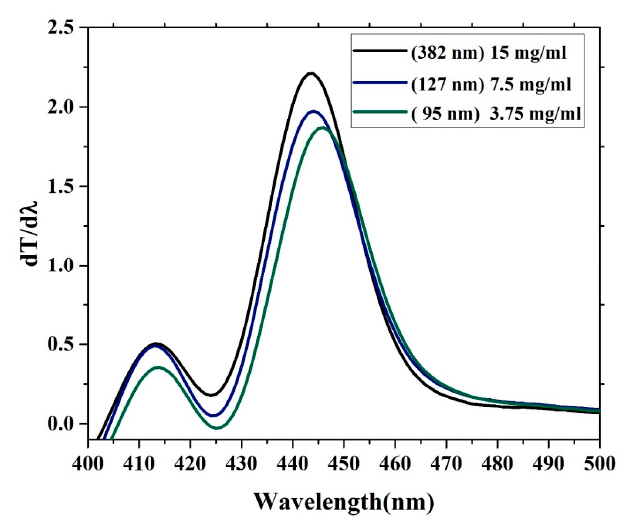
Figure 8. Change in transmission versus wavelength first-order derivatives of the transmission concerning the wavelength.